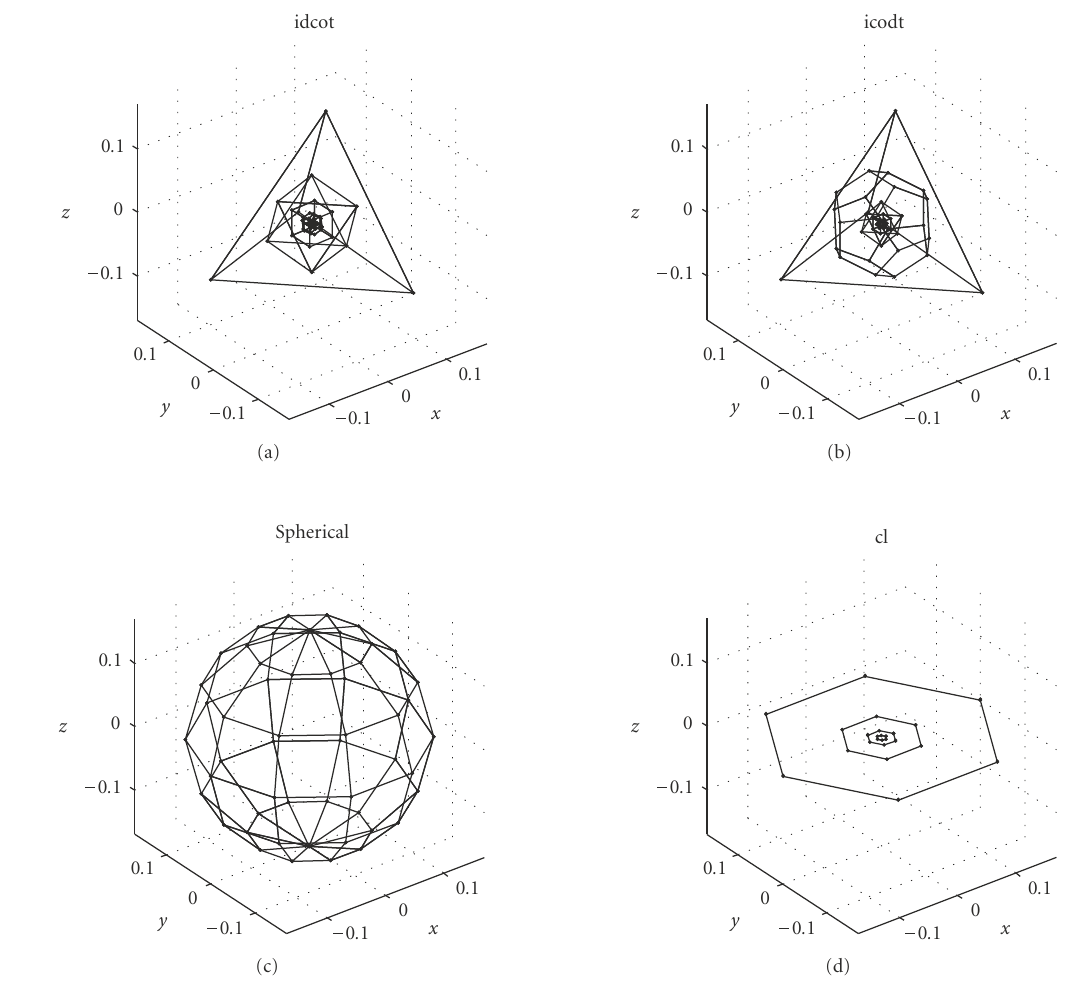
Figure 3: Microphone array geometries used for comparison: logarithmically spaced radii spherical array “idcot” (a) and “icodt” (b), regular spherical array (c) and double-height logarithmically spaced radii circular array (d).